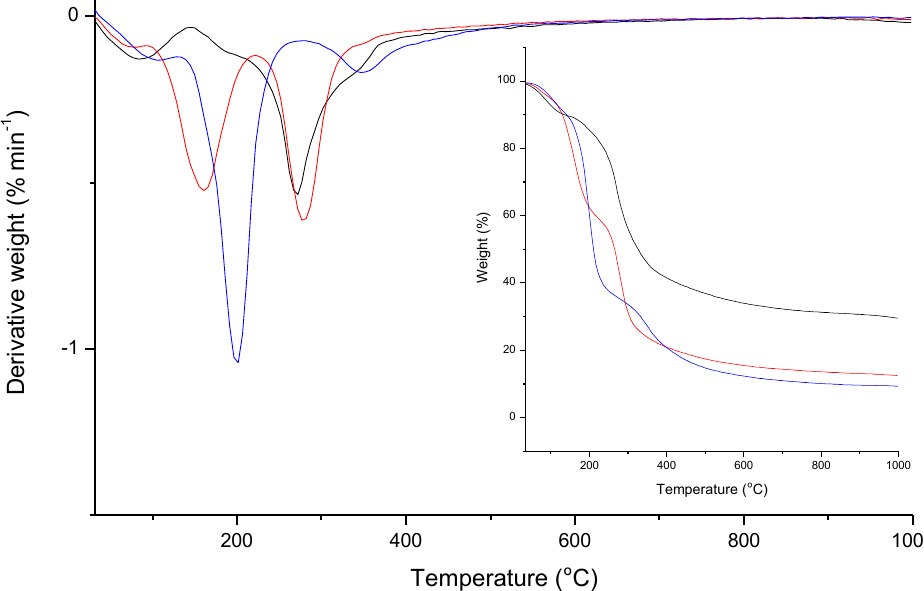
Figure 6. TGA thermograms and DTGA of chitosan films formed from chitosan solutions (1.5% wt. %) containing 5 wt. % of acetic acid (black line), lactic acid (red line) and citric acid (blue line).